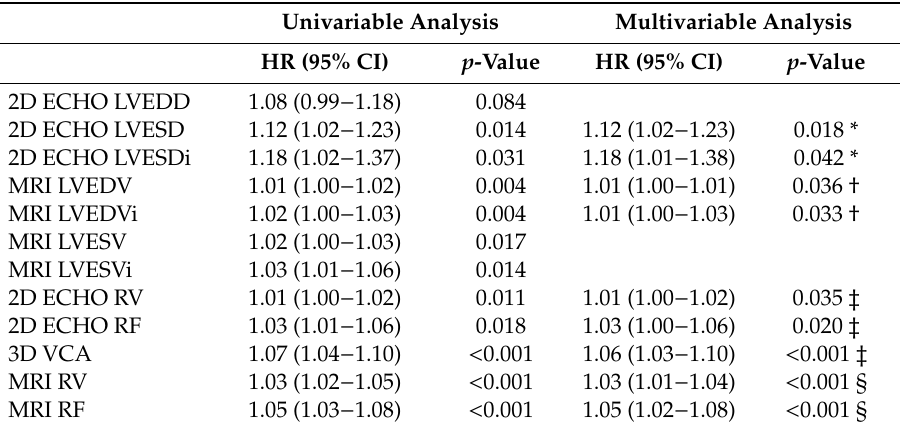
Table 4. Independent predictors of aortic valve